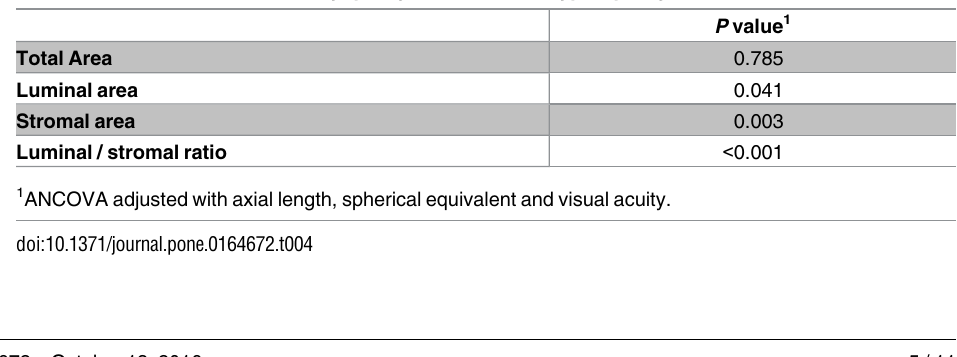
Table 4. Difference between amblyopic eyes and control hyperopic